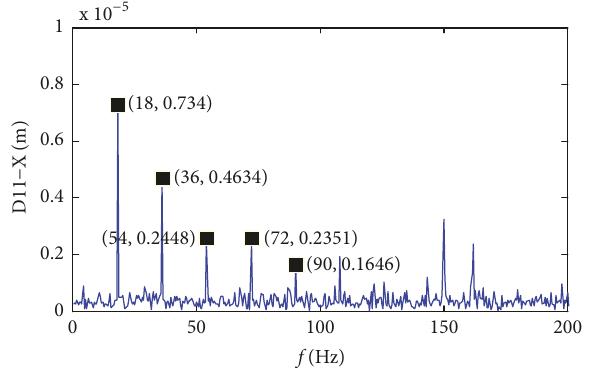
Figure 22: Frequency spectrum of D11 signal after filtering 50Hz. (no. 2015AA043005) and the National Natural Science Foun- dation of China (no.